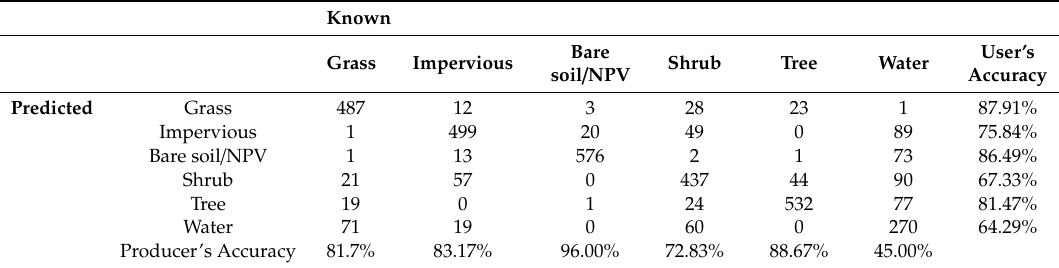
Table 1. Confusion matrix for NAIP only classification with overall accuracy of 78% and weighted overall accuracy of